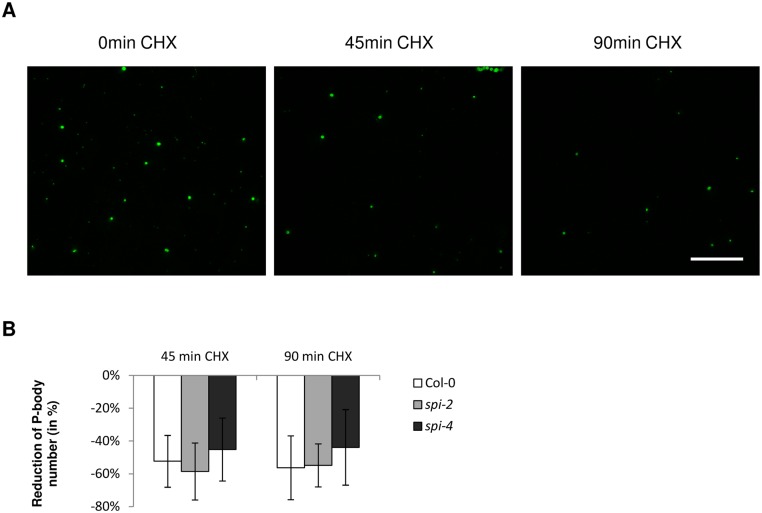
Blocking translation leads to a reduction of P-body number.Changes of P-body number were analyzed in whole leaf areas of transgenic plants expressing DCP1-YFP. (A) Whole leaf areas are presented before (0 min) and after continuous CHX treatments (45 min and 90 min). Scale bar: 50 μm. (B) Reduction of P-body number (in %) relative to untreated samples (time point 0) determined 45 min and 90 min after CHX treatment. Data denote the average from seven biological replicates. SD values represent standard deviations. No statistical differences were found between wild-type and spi mutants (Two-tailed student’s t test).